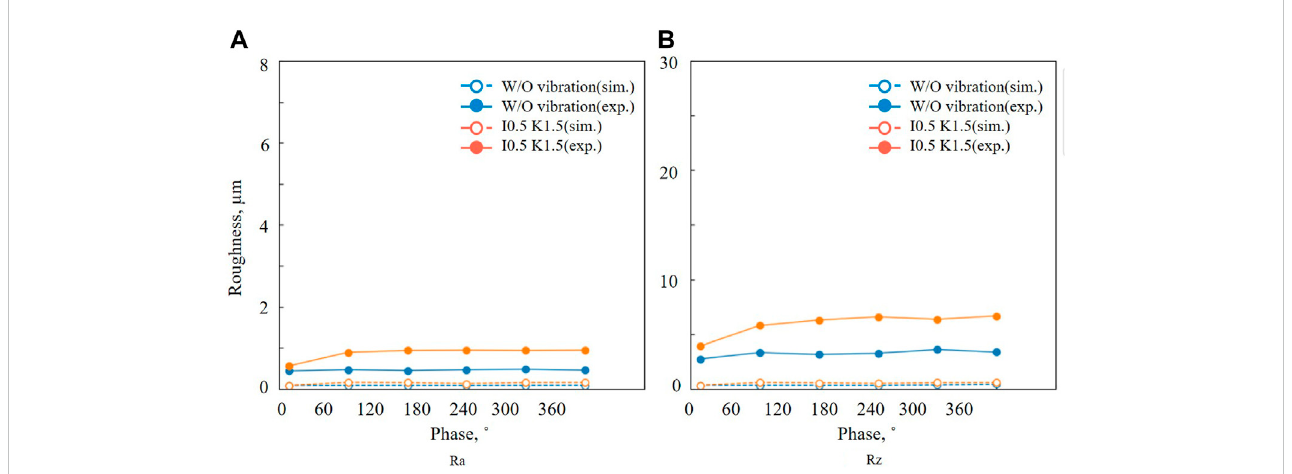
FIGURE 12 Results of surface roughness measurement for the proposed tool.